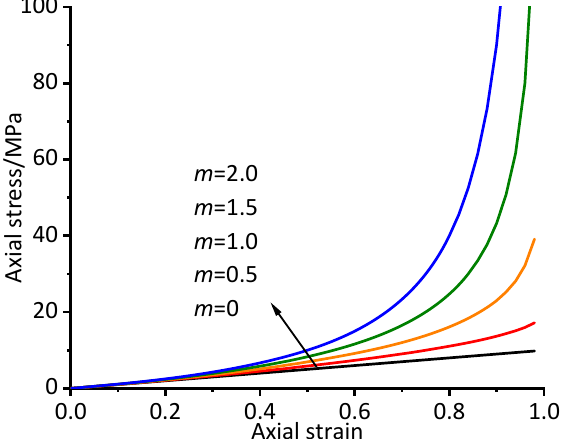
Figure 5. Stress ‒ strain curves for different m values ( E ni = 10 MPa). Figure 5. Stress-strain curves for different m values ( E